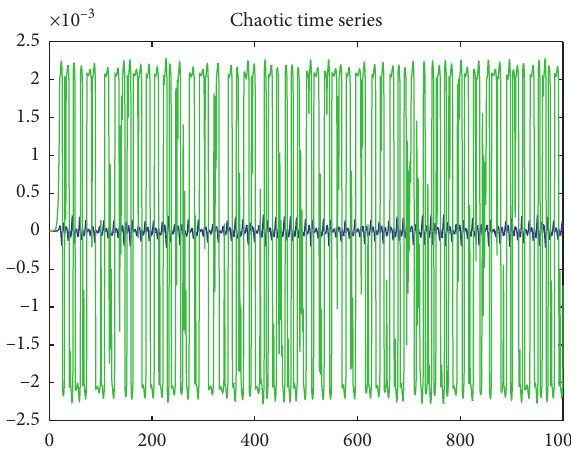
Figure 6: Chaotic time